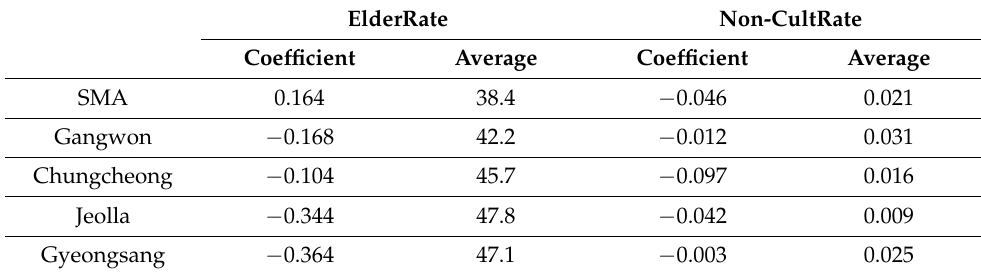
Table 13. Coefficients of the elderly population and fallow land by